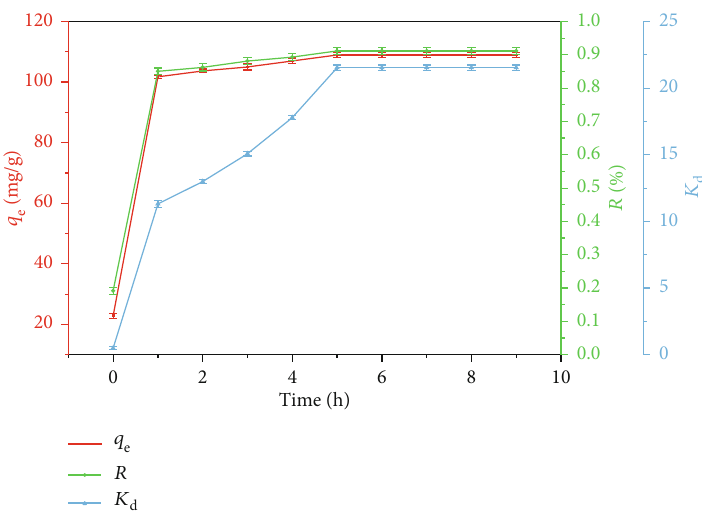
Figure 1: E ff ect of the contact time on GO adsorption on calcareous